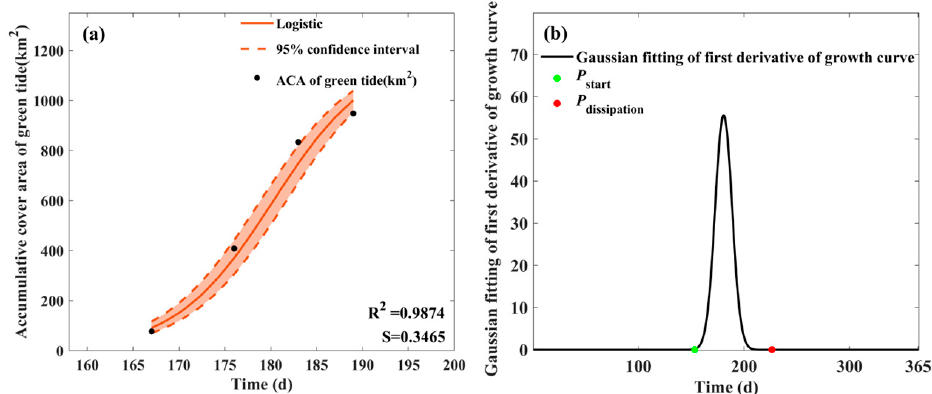
Figure 13. Forecasted start and dissipation times of the Yellow Sea green tide for 2022 (( a ) is Logistic growth curve fitting effect of the ACA of the Yellow Sea green tide (2022) and ( b ) is the forecast results of start and dissipation times of the Yellow Sea green tide for 2022).